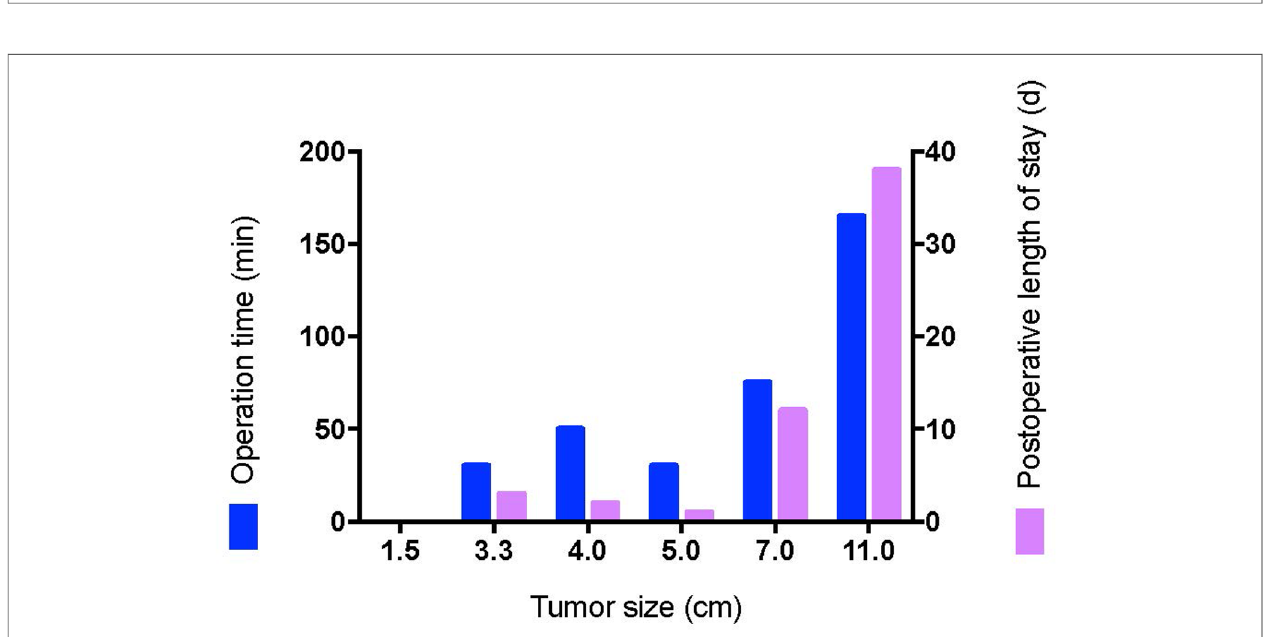
FIGURE 3 | The relationship between tumor size and perioperative